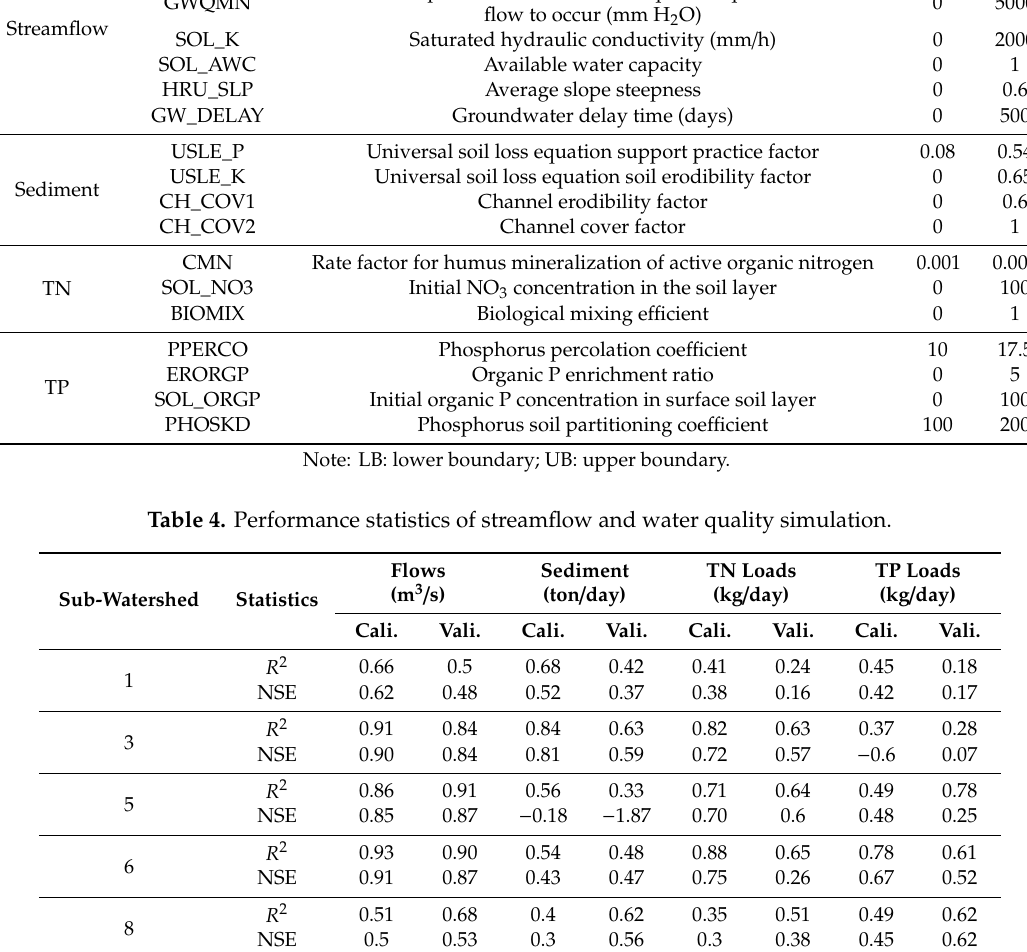
Table 3. Selected input hydrological and water quality parameters for model calibration.